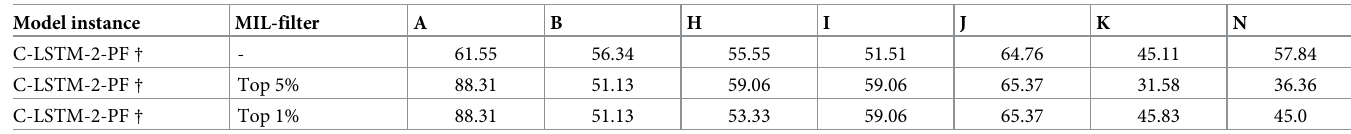
Table 6. Results on video-level for EOP(j), when applying a multiple-instance learning (MIL) filter during inference on the clip-level predictions. The column letters designate different test subjects. The model has never trained on EOP(j), and is the same model instance as in Tables 2, 5 and 7. Model instance